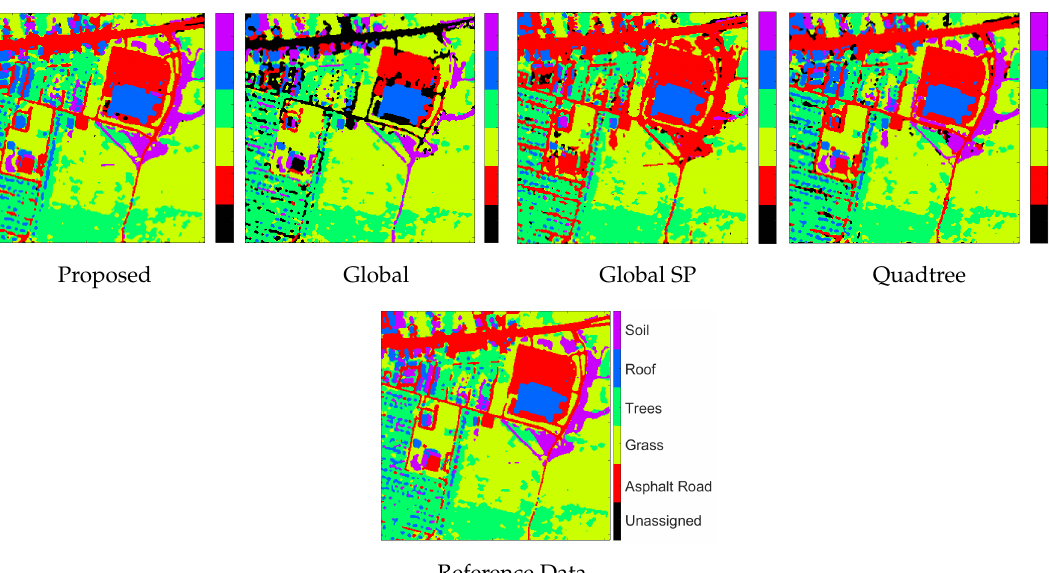
Figure 32. Comparison of extracted classification maps by different approaches with the proposed